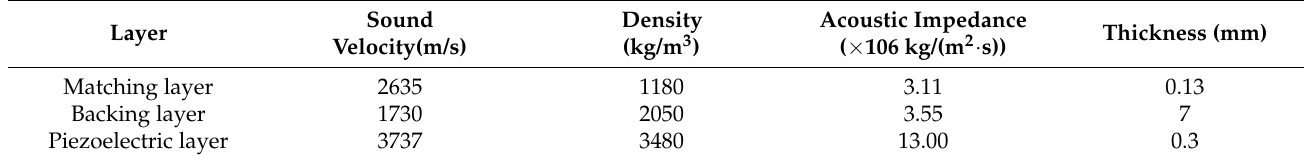
Table 2. The properties of the piezoelectric layer.